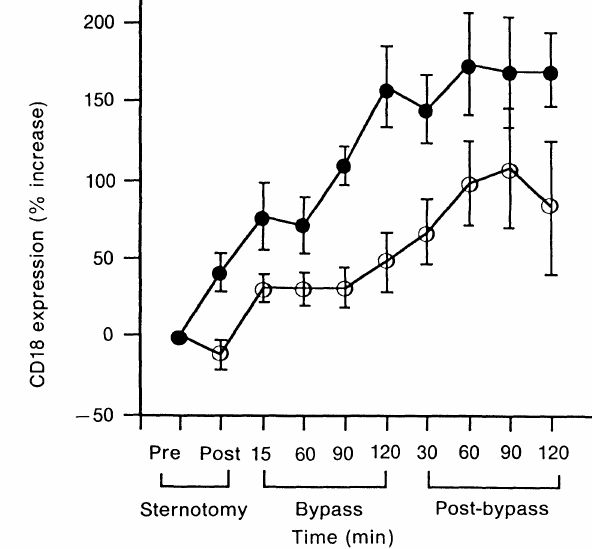
FIG. 3. NPC 15669 inhibition of increase in CD18 expression on neutrophils during CPB. Five piglets received NPC 15669 just prior to and during CPB (C), 10 mg/kg bolus followed by 6 mg/kg/h i.v.), and five received vehicle alone (O). Arterial blood samples were obtained at time points indicated. Anti-porcine CD18 antibody or buffer was added to 100#1 aliquots of whole blood and incubated on ice for 30 min. All samples were then labelled with FITC-GAMIg. Red cells were lysed and leukocytes fixed prior to measurement of cellular fluorescence. Fluorescence was measured on a linear scale. Values were converted to percentage increase over baseline and expressed as mean _+ S.E.M. (n 5 for each group). CD18 expression in the treated group was significantly less than that in the untreated group (p < 0.02, ANOVA for repeated